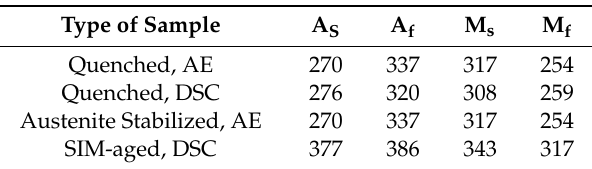
Table 1. Transition temperatures for the quenched, austenite stabilized and stress-induced martensite stabilized (SIM)-aged Ni 51 Fe 18 Ga 27 Co 4 single crystals, as obtained from DSC and acoustic emission (AE) measurements. The error bars are about ± 3 K.